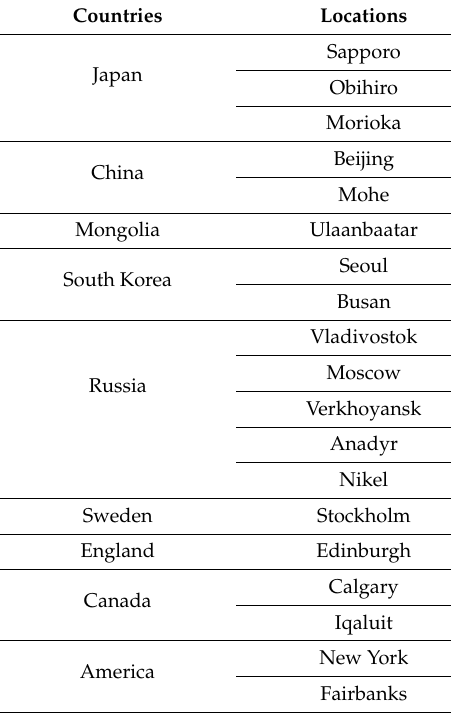
Table 6. Meteorological data colection